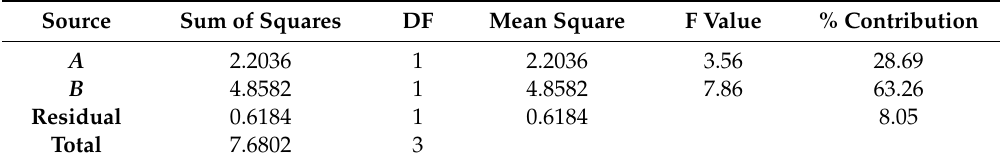
Table 8. Analysis of